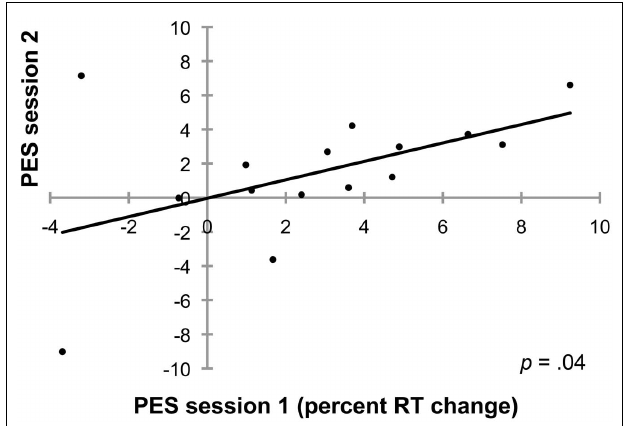
FIGURE 3 | Individual PES values (calculated as RT change in post-error trials relative to RT in correct trials) show a significant correlation between experimental session 1 and experimental session 2. There were on average 4.6months between the first and the second